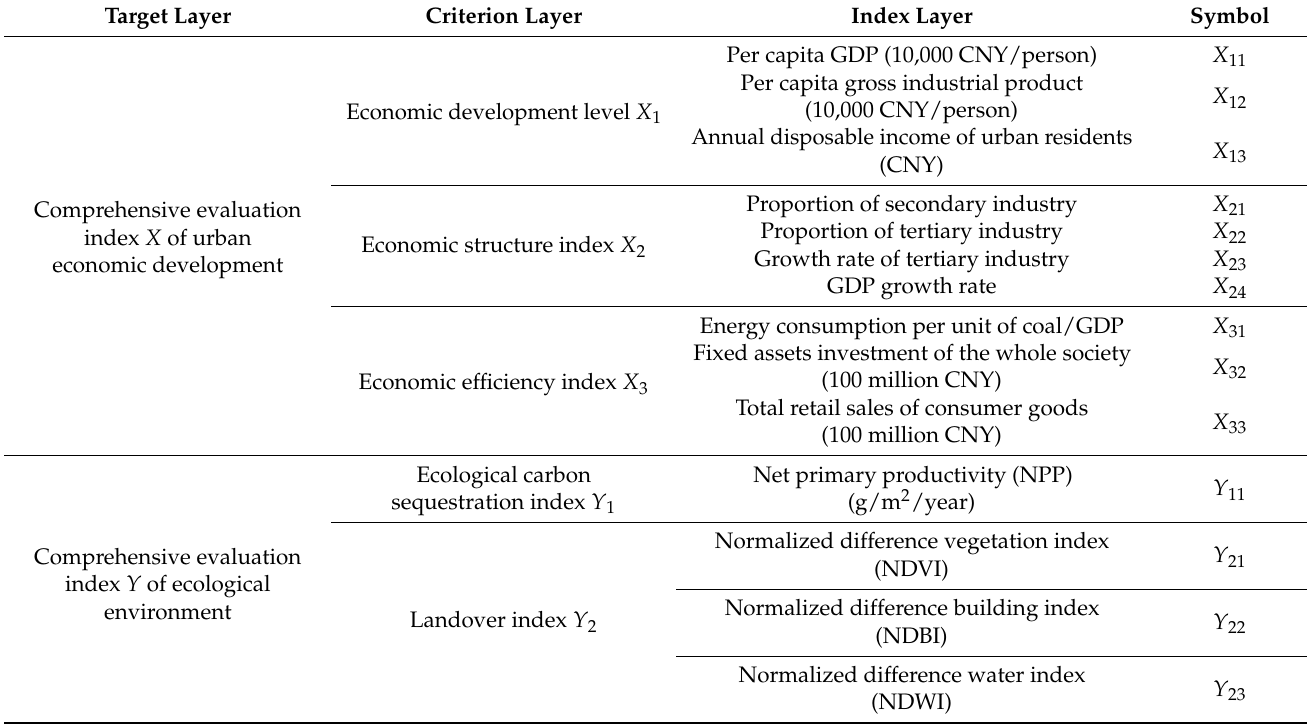
Table 1. Evaluation index system of economy and ecological environment in